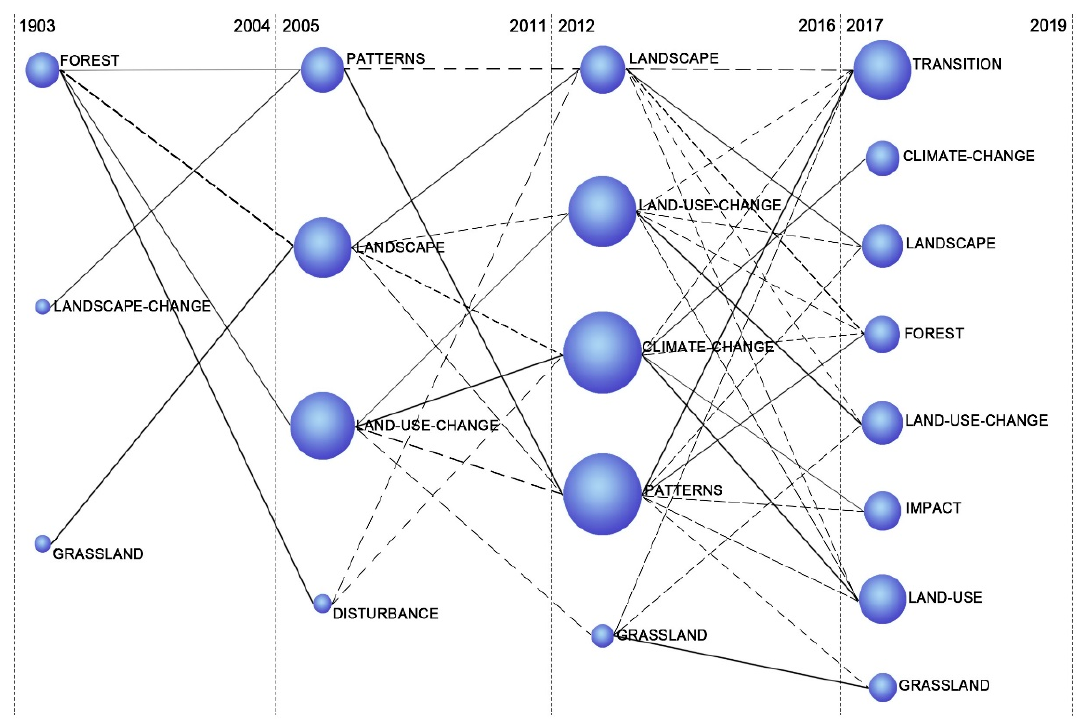
Figure 15. Thematic evolution of the farmland abandonment research field (1900–2019).